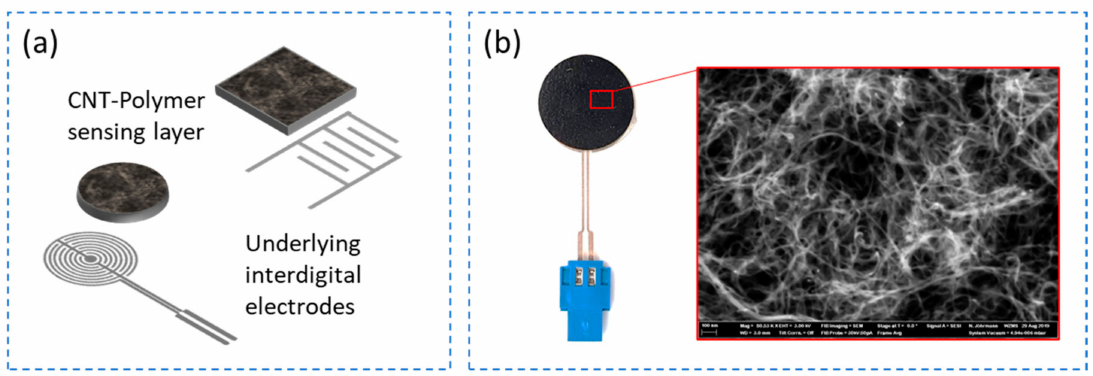
Figure 9. ( a ) Different interdigital electrode structure with conductive sensing layer on top and ( b ) CNT-PDMS based pressure sensor with circular sensing and interdigital electrode layers and an SEM image representing the distribution of CNT network in the